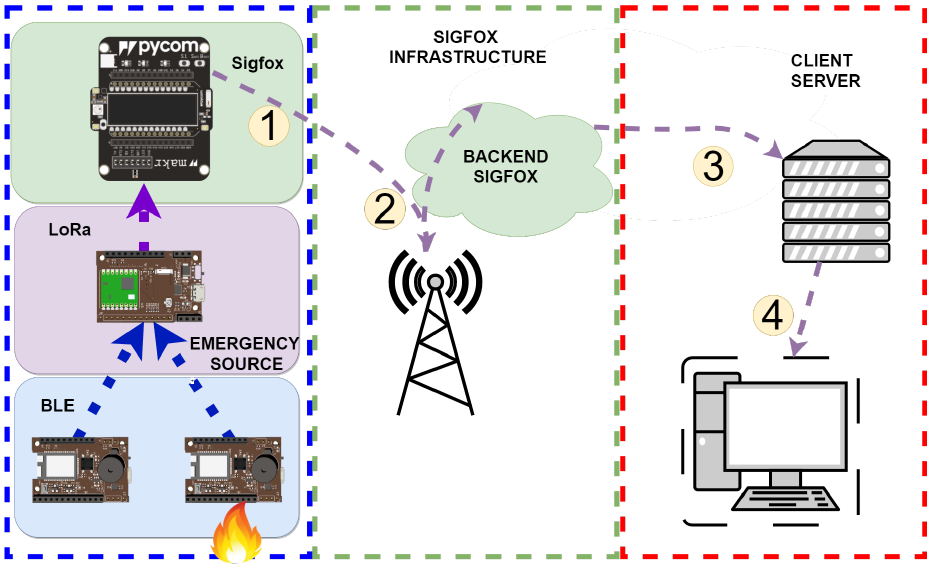
Figure 2. Summary diagram of the proposed emergency